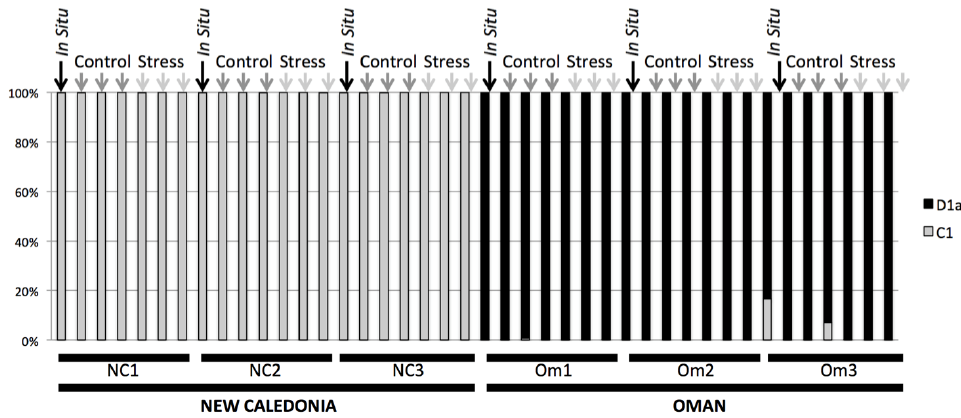
Figure 3 . Composition of the Symbiodiniaceae community in each colony in situ and in controlled and stressful experimental